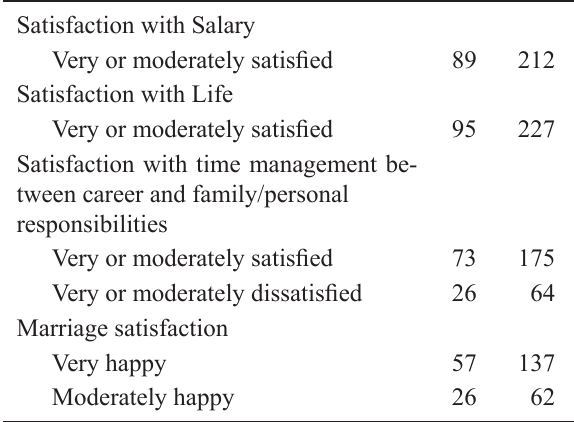
Table 3 – Results of satisfaction.